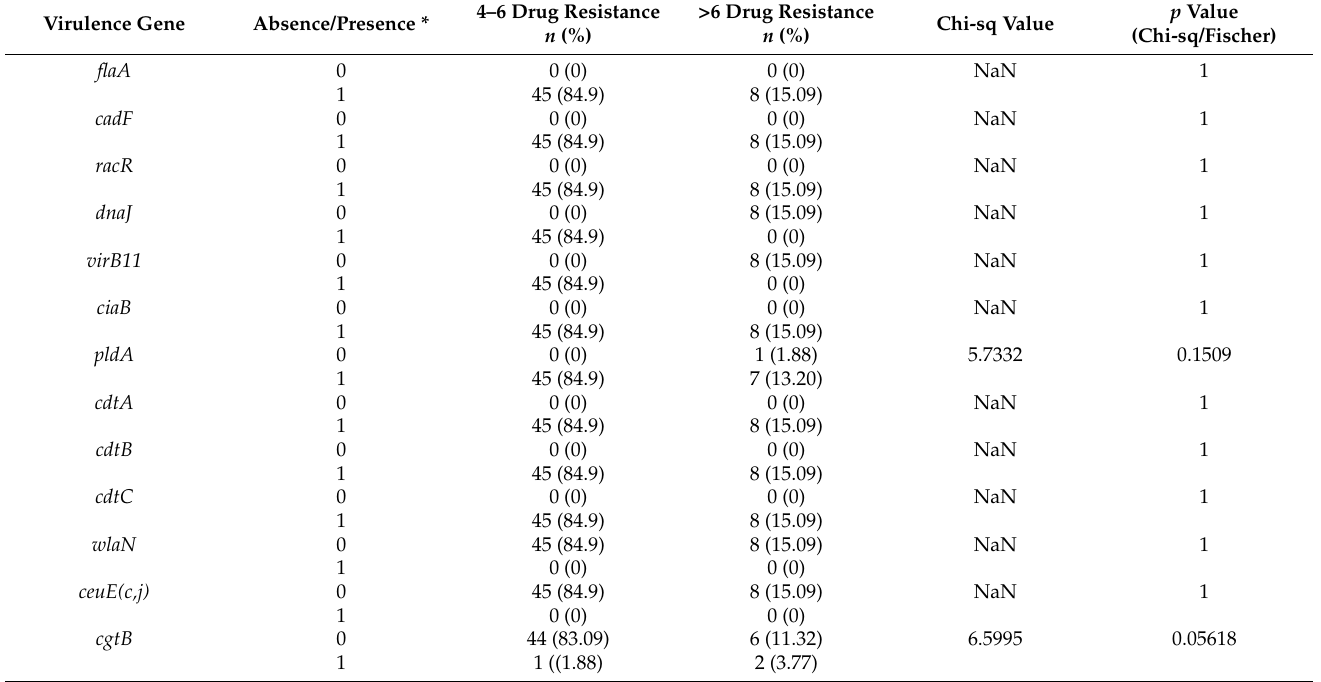
Table 3. Associations between virulence genes and multidrug resistance in C. coli isolates ( n =